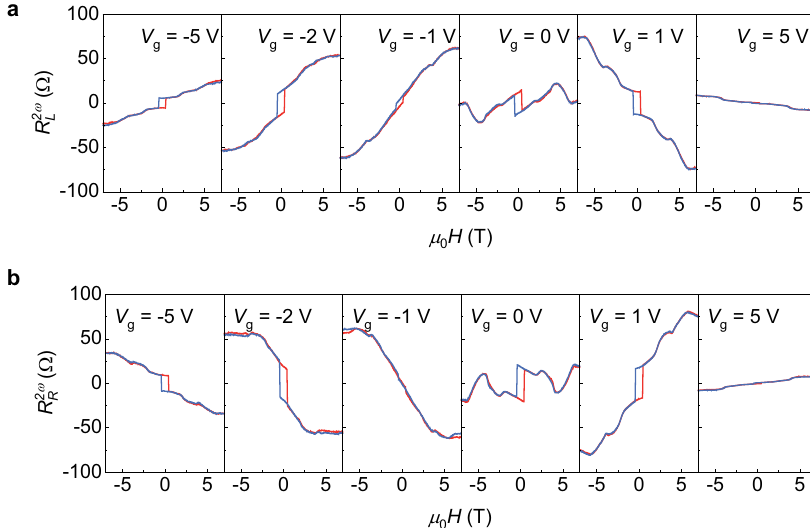
Fig. 4 | Non-reciprocal resistance at various top gate voltages. a Non-reciprocal resistance as a function of magnetic fi eld measured at the left edge. b Non- reciprocal resistance as a function of magnetic fi eld measured at the right edge.